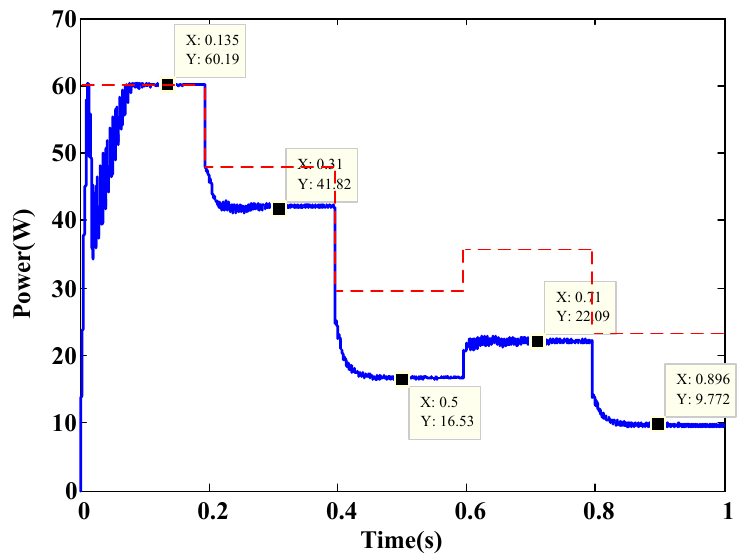
Figure 21. Variable Δ Δ P I  power tracking results 1.